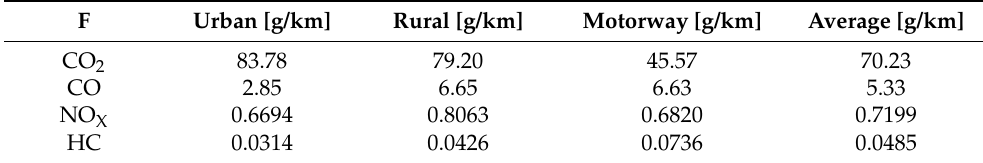
Table 3. RDE test Table 3. RDE test results.